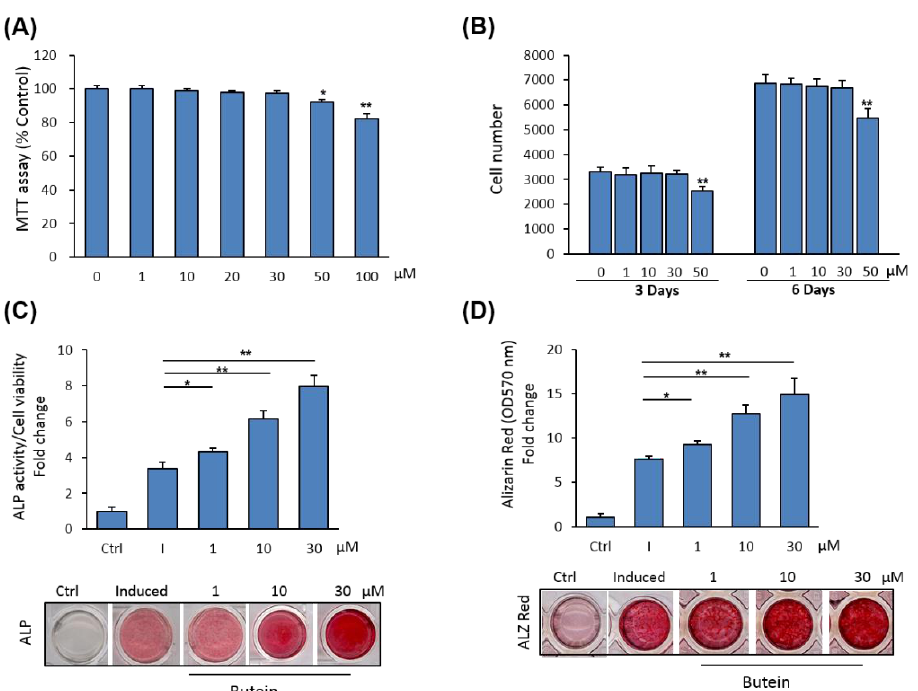
Figure 1. Butein promotes osteoblast differentiation of mBMSCs. ( A ) Cytotoxicity of butein on primary cultures of mBMSCs. Cell viability was determined by an MTT assay. ( B ) The effect of butein at different concentrations on the cell proliferation of BMSCs, as measured by counting cell numbers after 3 and 6 days of treatment. Cells were either non-treated (0) or treated with different concentrations of butein. ( C ) Dose-dependent stimulatory effect of butein on osteogenesis of mBMSCs measured by quantification of ALP activity and ( D ) matrix mineralization with Alizarin red staining after 6 and 12 days of induction, respectively. Cells were either non-induced (Ctrl, control), or induced with an osteogenic cocktail in the absence (I + DMSO) or the presence of different concentrations of butein. Values were represented as fold changes over the control non-induced cells. Stained images were shown. Values are mean ± SD of three independent experiments, (* p <0.05, ** p <0.005 compared to differentiated cells without butein).